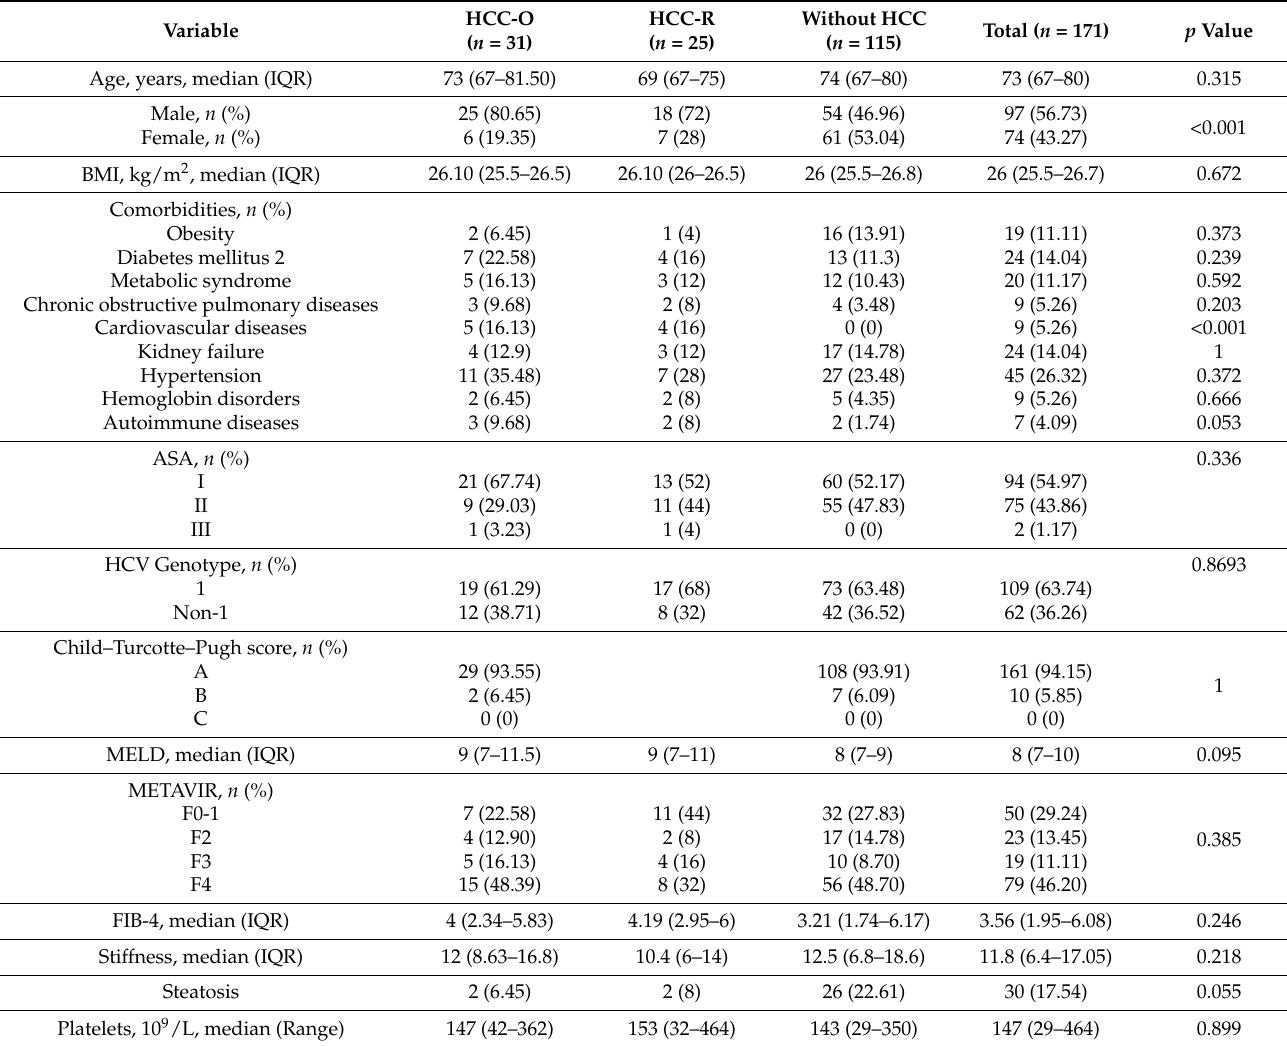
Table 1. Characteristics of the elderly population